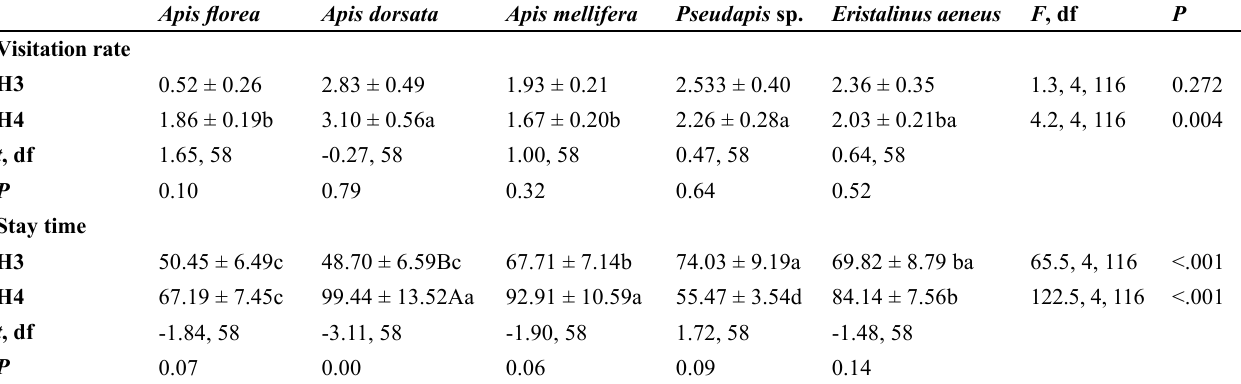
Table 4 . Mean (± SE) number of pollinators visiting and the pollinator stay time on bird-susceptible and bird-tolerant cultivars.